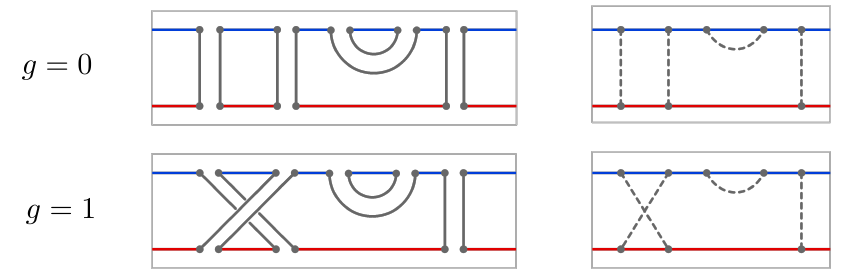
Figure 5: Alternative ways of representing building blocks of matrix theories. Left: double line notation customary in matrix field theory. Right: ‘impurity diagram rep- resentation’ customary in the physics of random